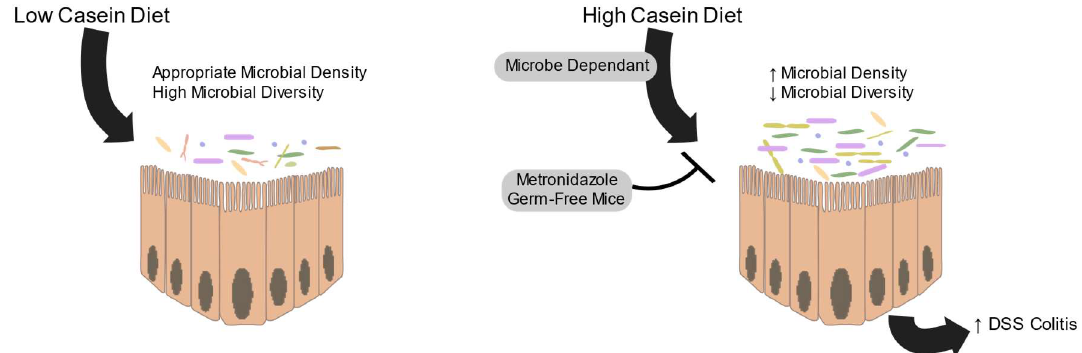
Figure 3. High casein diets cause an increase in microbiota density and a decrease in microbial diversity. This change in the microbiota results in an increase in DSS colitis severity. High casein diets do not have this effect in germ-free mice or if microbial density is controlled using metronidazole.